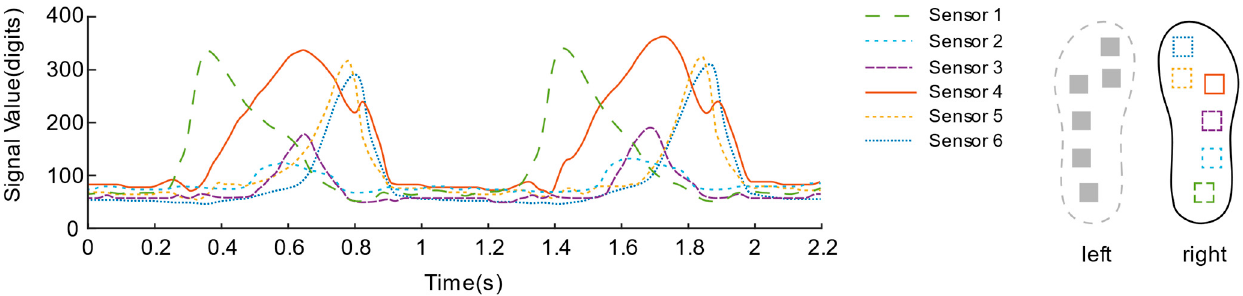
Figure 15. Right foot plantar pressure sensor signal during the bipedal walking experiment.